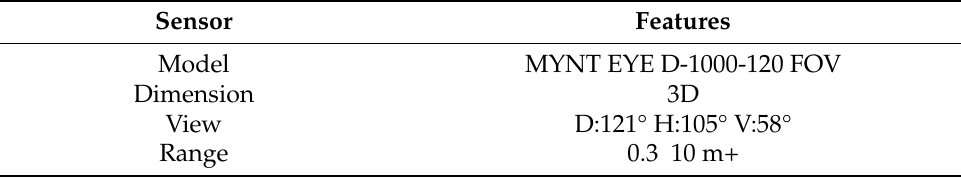
Figure 1. Pioneer 3DX equipped with MYNT EYE camera. Table 1. Specifications of the MYNT EYE